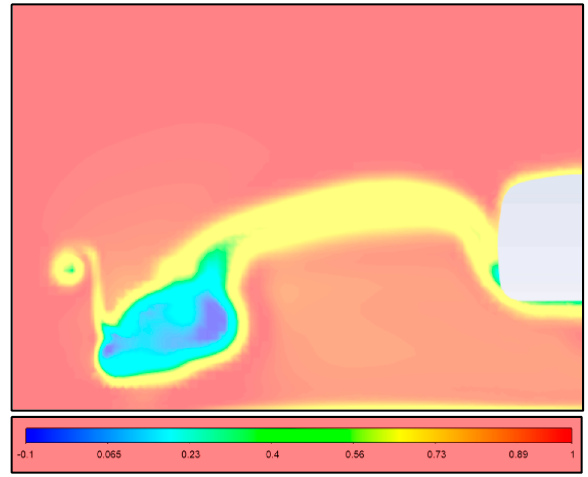
Figure 9. Total pressure coefficient at plane z = − 0.9 (AOA of 30 ◦ , 32 ◦ , and 34 ◦ ).